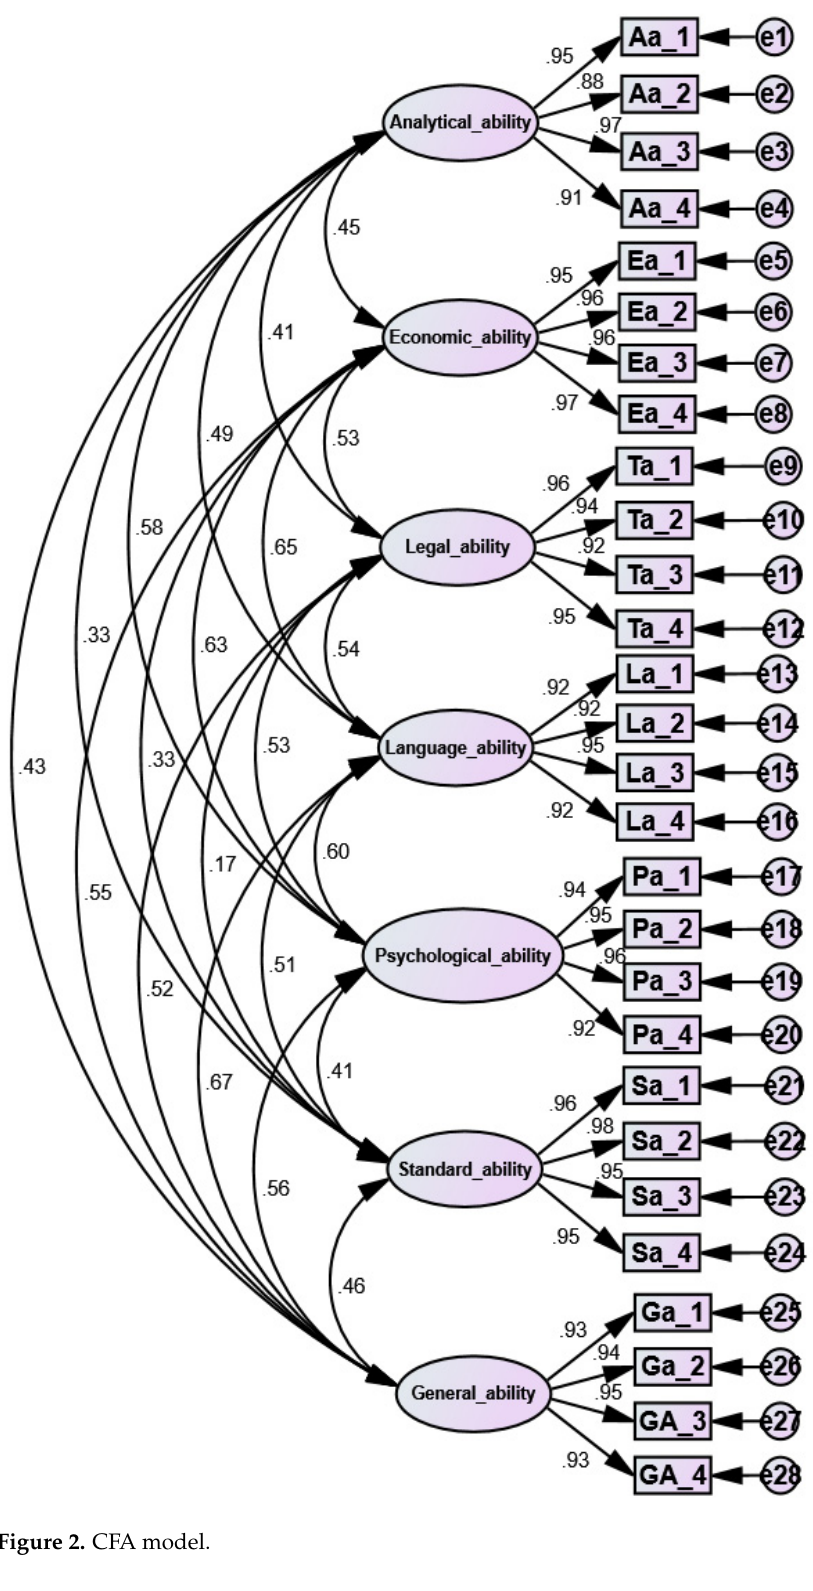
Figure 2. CFA Figure 2. CFA model.